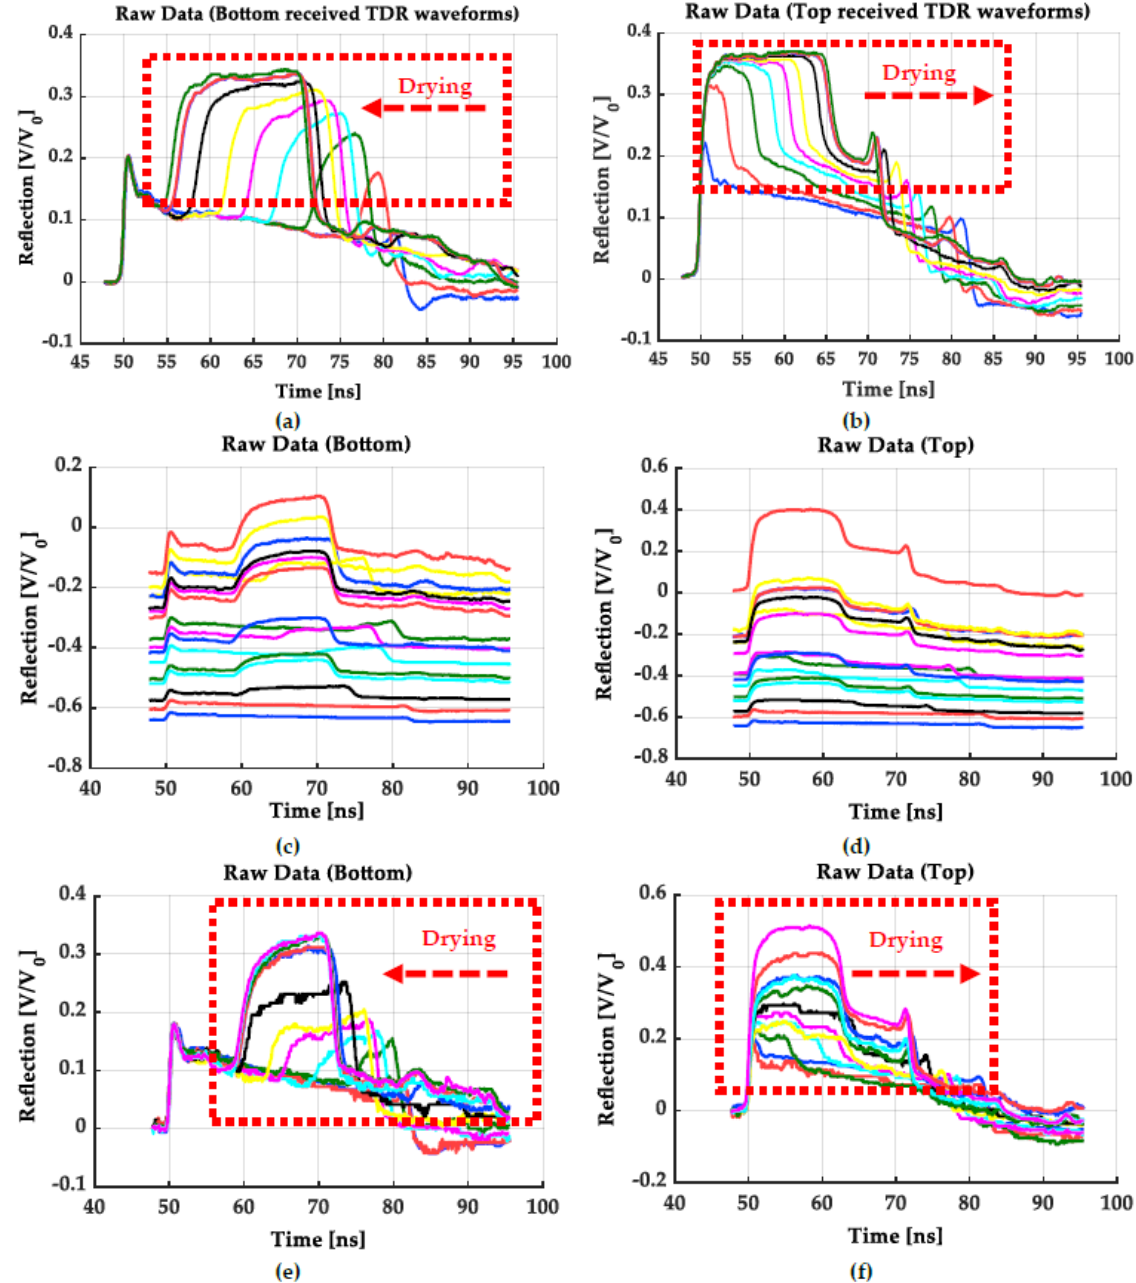
Figure 15. The TDR waveforms detected through the SDM X50 multiplexer: ( a ) a successful demo of TDR waveforms detected at the bottom end of an FRC sensor; ( b ) a successful demo of TDR waveforms detected at the top end of an FRC sensor; ( c ) a failure demo of TDR waveforms detected at the bottom end with the multiplexer-induced underestimation of reflection coefficients; ( d ) a failure demo of TDR waveforms detected at the top end with the multiplexer-induced underestimation of reflection coefficients; ( e ) a demo of rescued TDR waveforms detected at the bottom end after applying the correcting step introduced in this work; ( f ) a demo of rescued TDR waveforms detected at the top end after applying the correcting